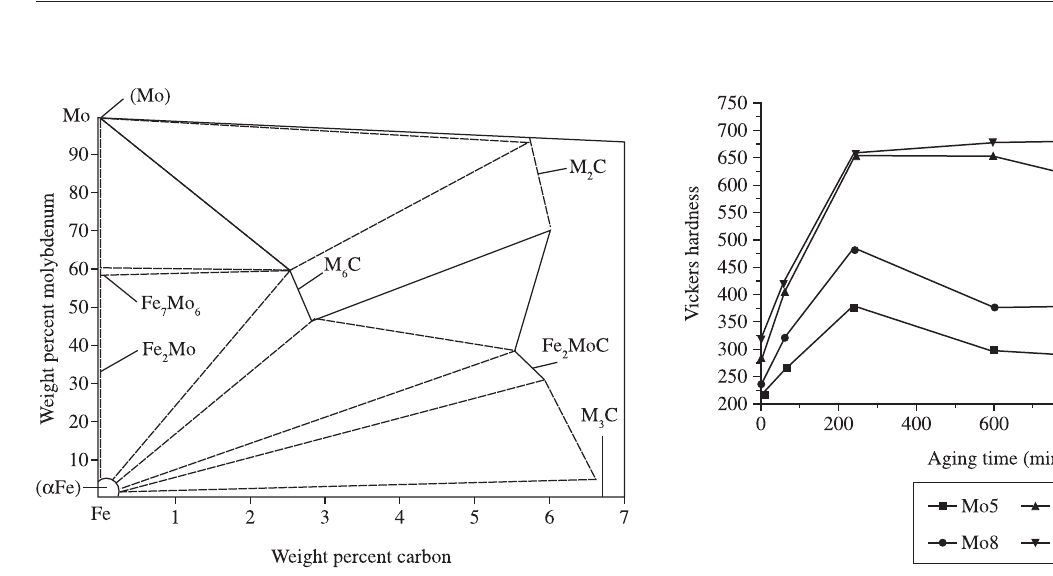
Figure 2. Variation of Vickers hardness as a function of the magnetic aging of Fe-Mo-Ni-C alloys containing different molybdenum